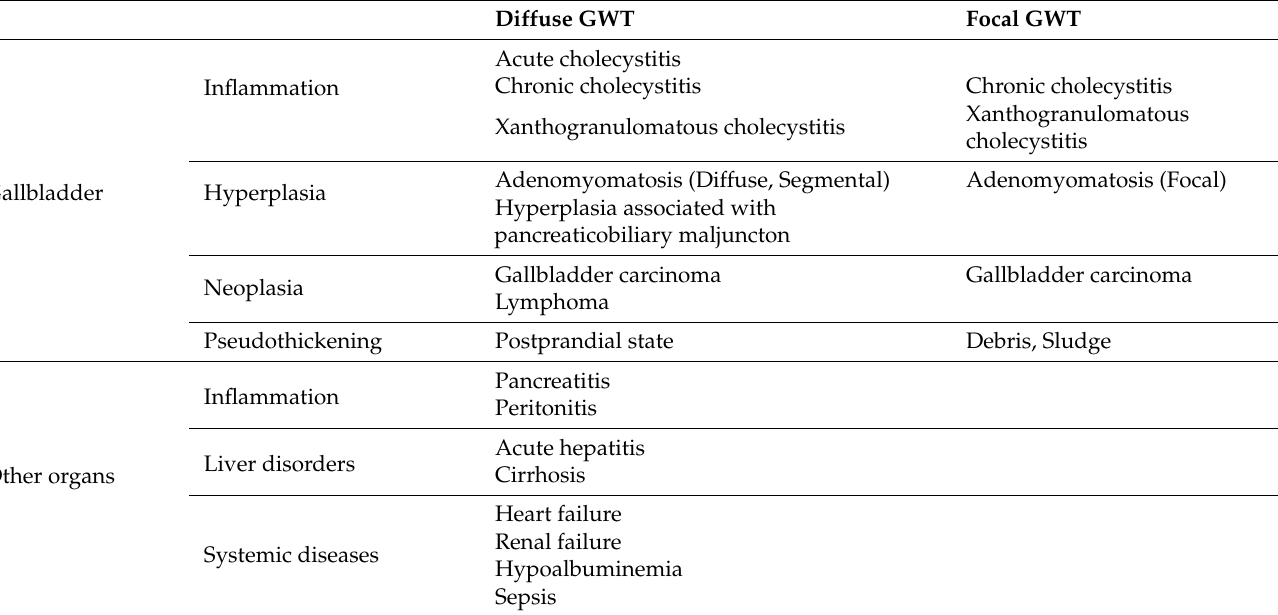
Table 2. Causes of GB wall thickening